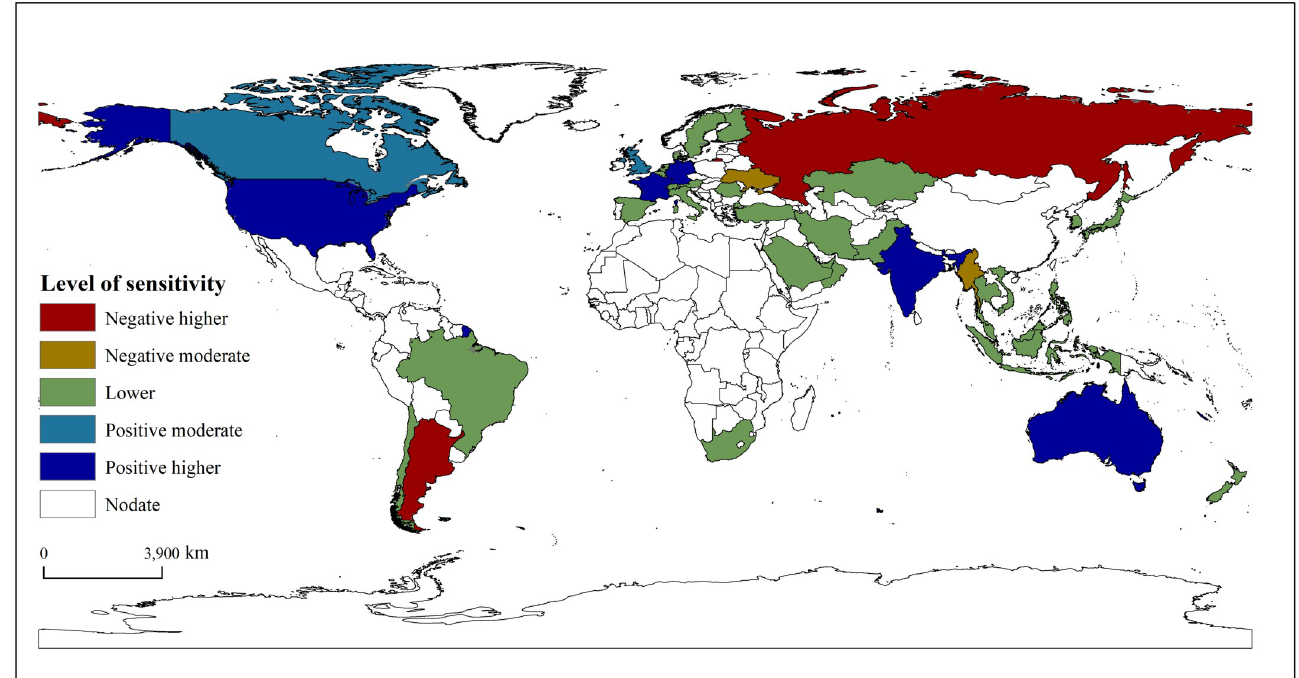
Fig 2. Sensitivity of China to its grain trade